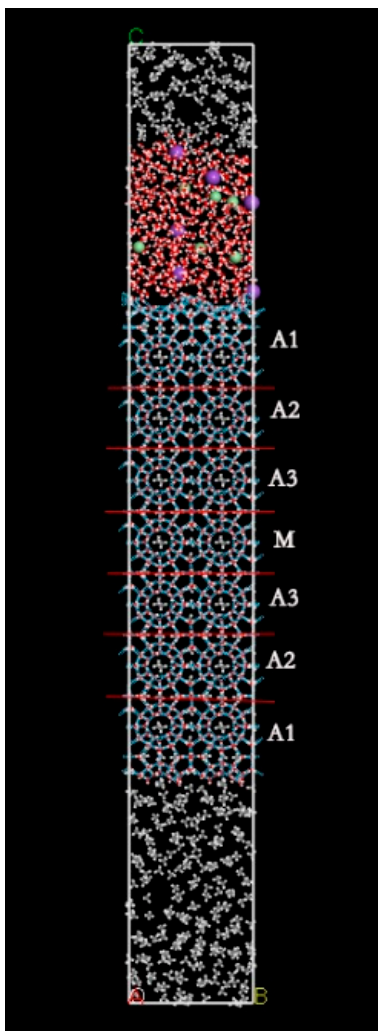
Figure 4. Layer division fashion for the hydrate system. Three layers near the liquid phase with the corresponding three layers near the gas phase (A1, A2, A3), and the middle layer (M).